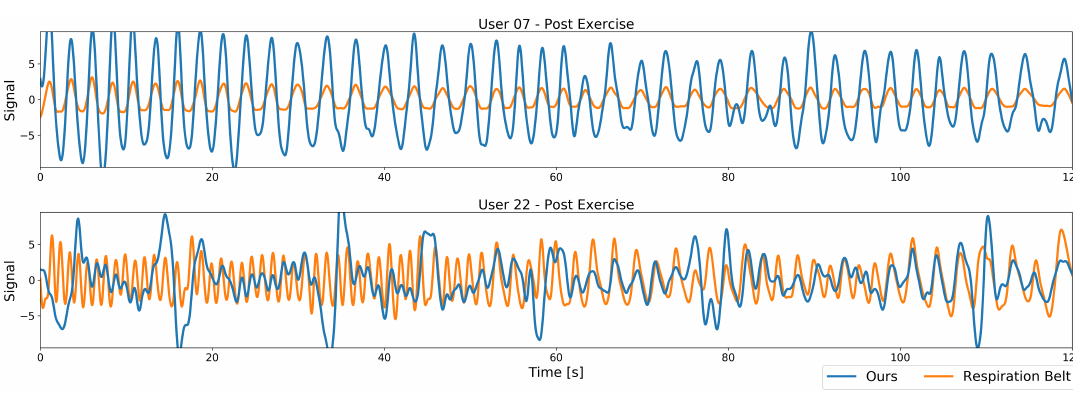
Figure 7. Comparison plots between the output of the chest-worn respiration belt (in orange) and the output of our proposed model (in blue), for the post-exercise condition (going from a fast respiration rate in the beginning to slower one over time). The top segment has a PCC of 0.95 and an accuracy of 100%, both signals match well in terms of frequency. The bottom segment has a PCC of 0.26 and an accuracy of 22%, with the larger peaks on the left in our output due to the user occasionally tilting the torso forward and occluding the throat region with the